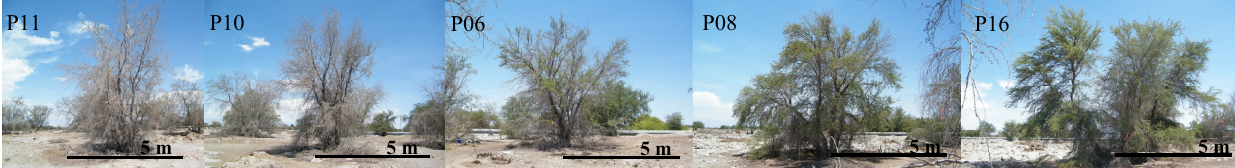
. From left to right: 0, vis